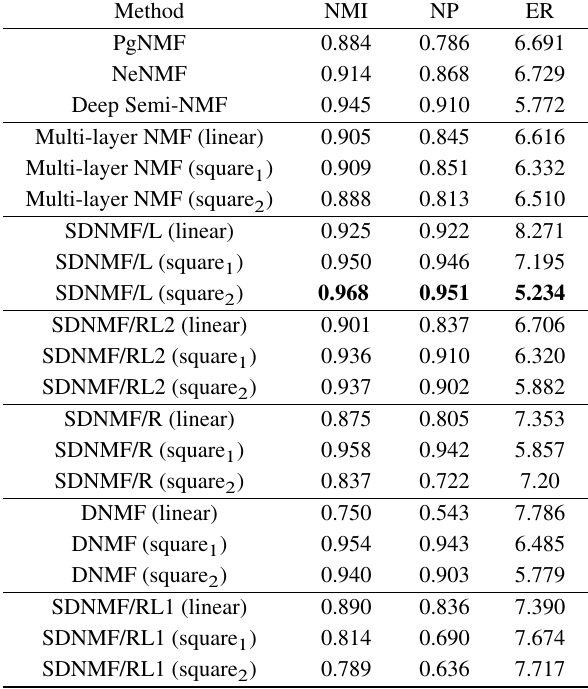
Note: All results from deep models were generated under layer size = [600, 160], while the results of PgNMF and NeNMF were obtained with k = 160. outperforms PgNMF, NeNMF, and multilayer NMF in NP and NMI, even without the nonlinear transformation with the root function. The results that SDNMF/L generated better classification results than the single- layer NMF indicates that both the sparse strategy and the optimization strategies of SDNMF/L play important roles in its good performance. In particular, the sparsity constraints for all the columns of W help to extract localized features and to learn class-specific deep features contributing to more distinctive representations for classification. The fine-tuning process in the optimization approximates the original data more closely. As for the comparison with deep semi- NMF, a gap exists between linear SDNMF/L